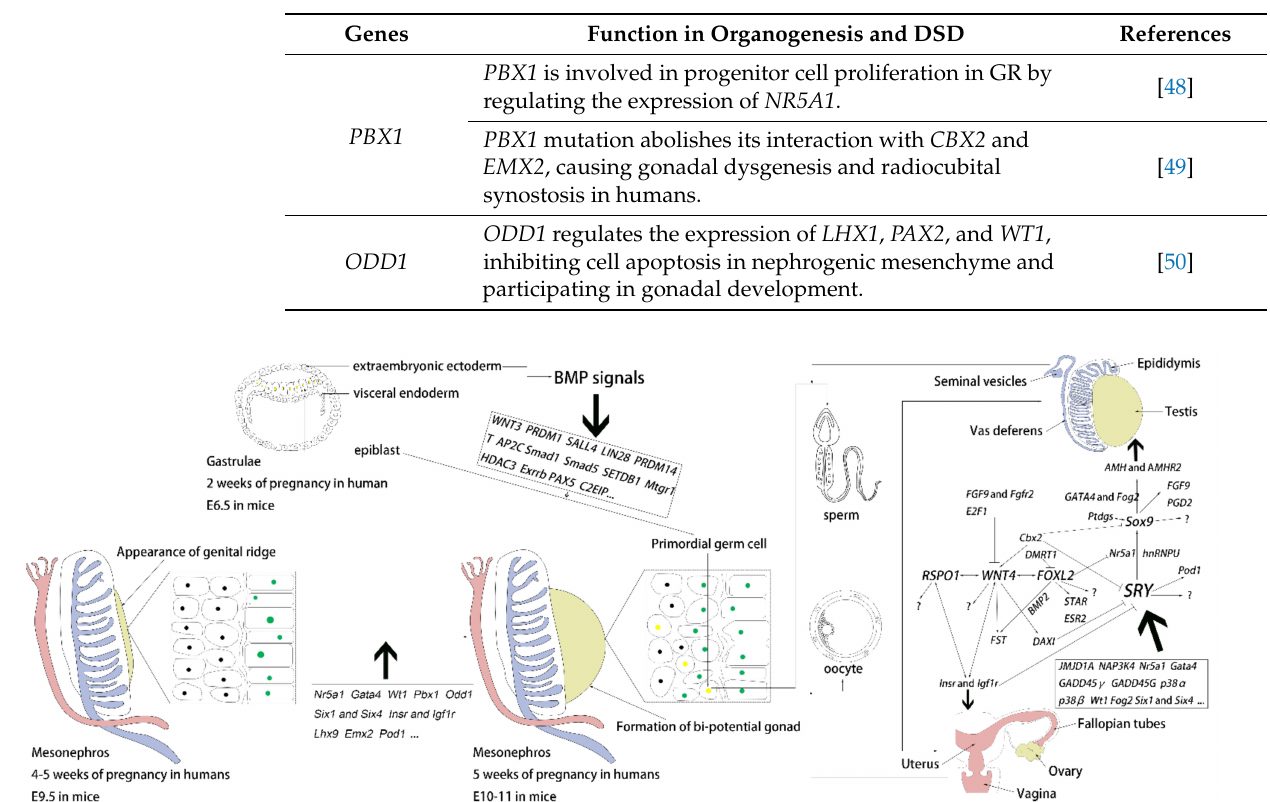
Figure 1. Schematic illustrations of the development of gonad and primordial germ cells (PGCs). At 4–5 weeks of pregnancy in humans (E9.5 in mice), coelomic epithelial cells (green) start to proliferate on the ventromedial surface of the mesonephros, and the genital ridge (brown) appears. At five weeks of pregnancy in humans (E10–E11 in mice), coelomic epithelial cells continue to proliferate and form bipotential gonads under the regulation of NR5A1 , GATA4 , etc. Subsequently, bipotential gonad differentiates into testis and ovary, respectively, through a sex-related genes antagonistic network. Among them, SRY , WNT4 , RSPO1 , and FOXL2 factors. In addition, the Wolffian duct (blue) and Müllerian duct (pink) form epididymis, vas deferens, and seminal vesicles or fallopian tubes, uterus, and part of the vagina, respectively. On the other hand, PGCs originate from a subpopulation of cells in the proximal epiblast (yellow). At two weeks of pregnancy in humans (E6.5 in mice), extraembryonic ectoderm and visceral endoderm secrete signals BMP signals, in turn, activate